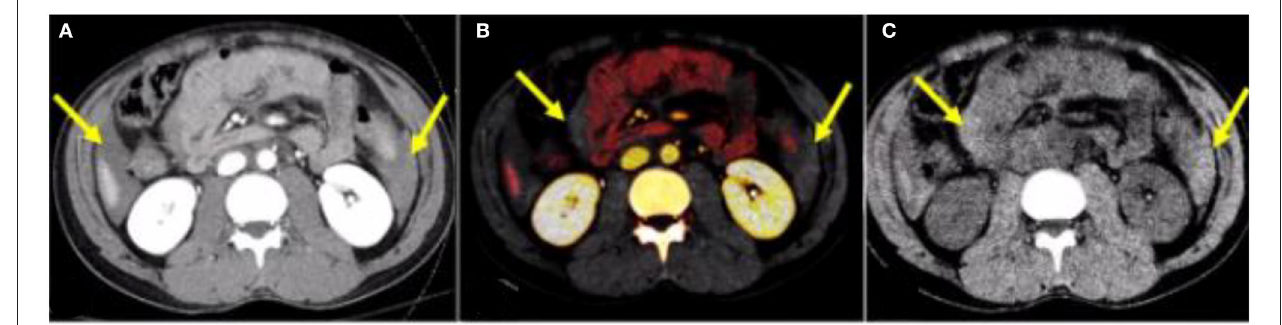
FIGURE 1 | A 28-year-old male patient—after a motor vehicle accident. (A) Conventional mixed DECT image demonstrates free fluid in the abdomen (yellow arrows). (B) Iodine overlay images increase the conspicuity of free fluid by differentiating enhancing bowel from non-enhancing fluid (yellow arrows). (C) DECT VNC accentuates the hyperattenuating nature of the hemoperitoneum. DECT, dual-energy CT; VNC, virtual non-contrast.